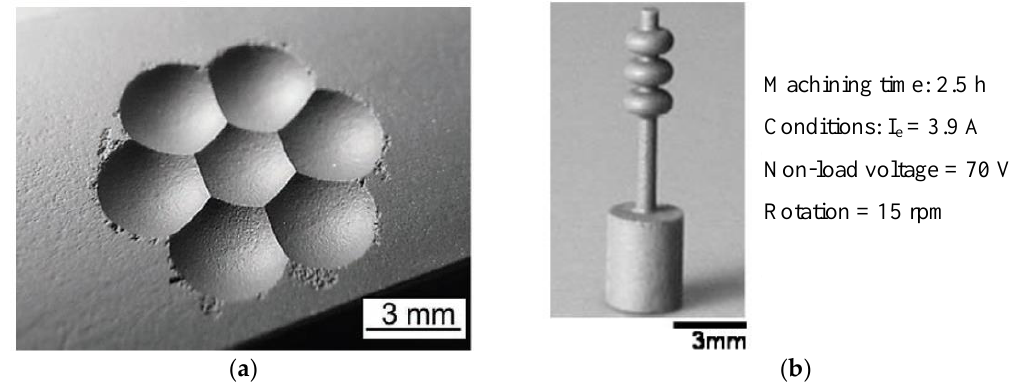
Figure 4. ( a ) Die for fly-eye lens machined by EDM in Si 3 N 4 ceramics. (Reproduced with permission from [53]) ( b ) small product on Silicon nitride using Wire EDM. (Reproduced with permission from [54]).